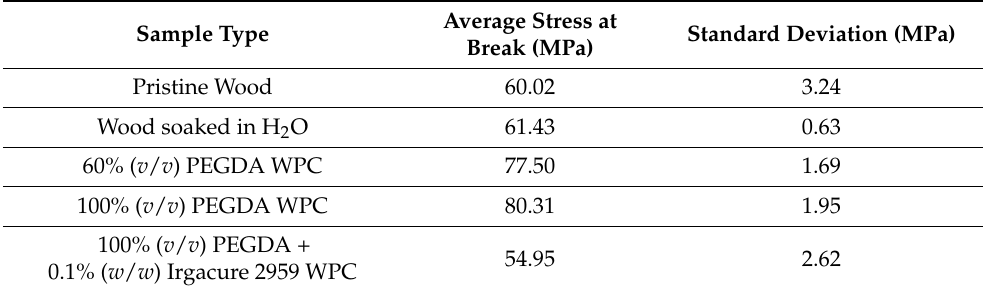
Table 1. Average flexural strengths for various sample types. All samples were treated with DBD plasma except the last sample in the table, which was treated with UV light. Sample size: N =